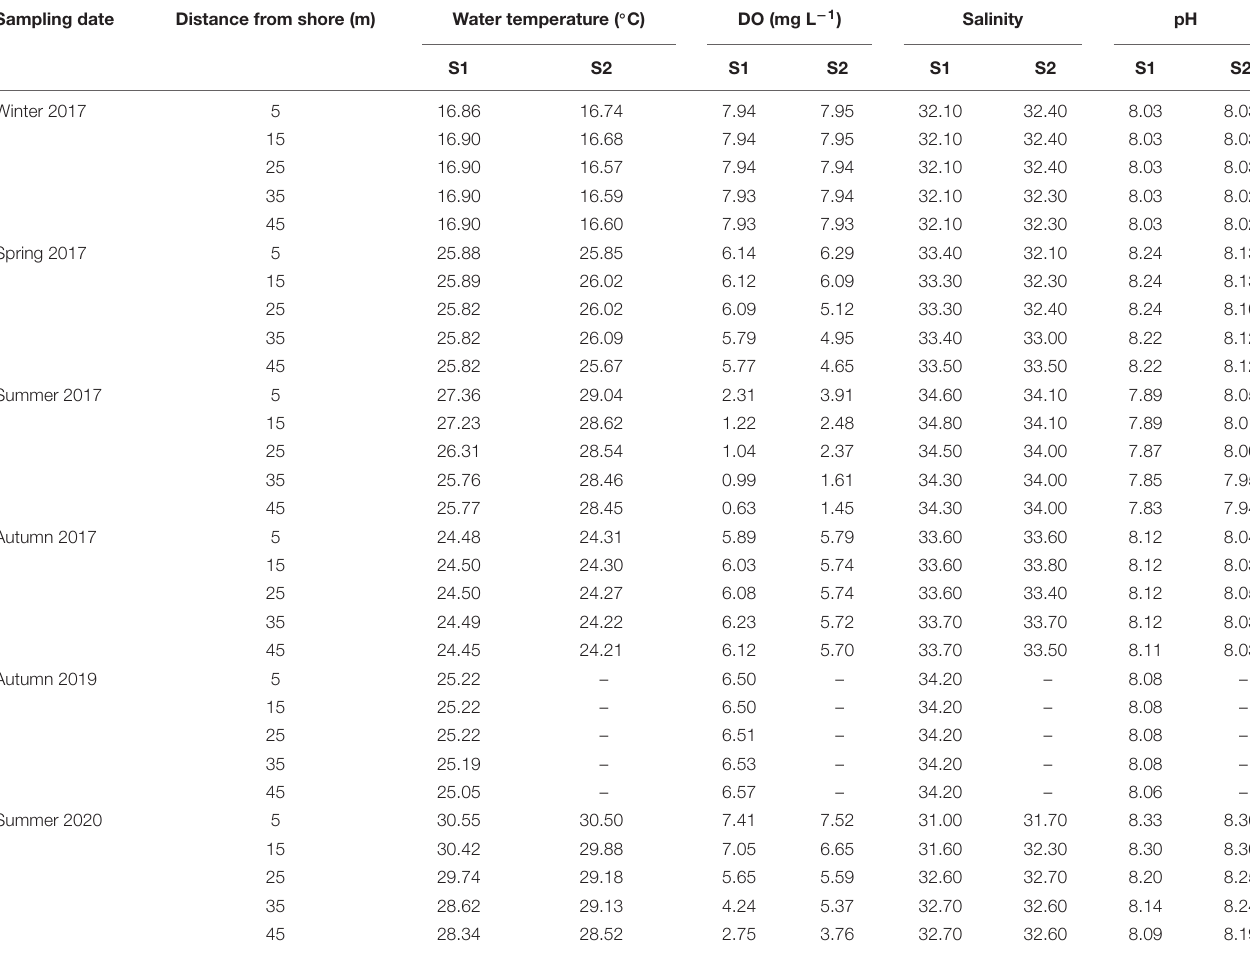
TABLE 2 | Near-bottom water parameters at survey sites,